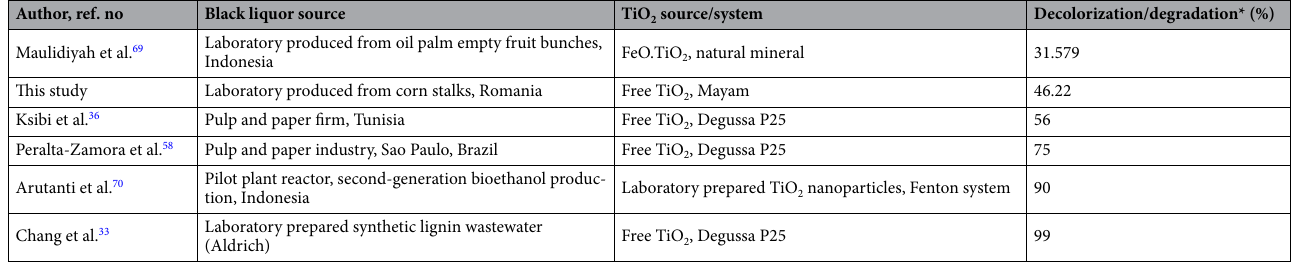
Table 8. Comparison of photochemical decolorization of various black liqueurs. *The highest reported